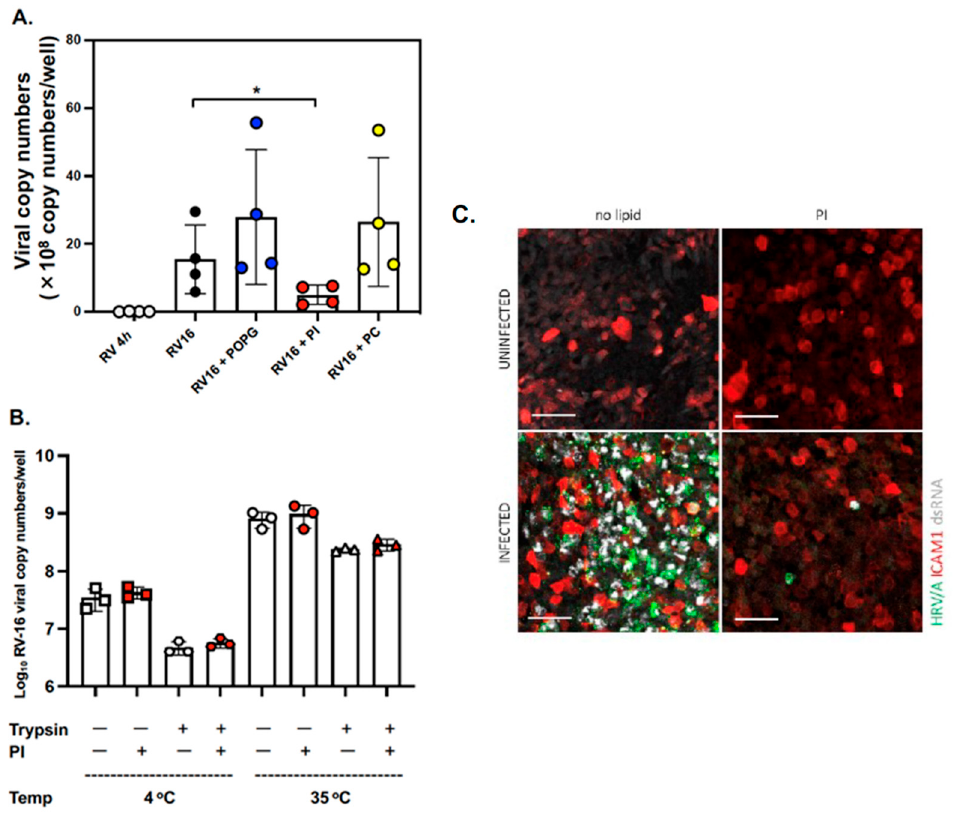
Figure 1. PI markedly inhibits RV-A16 replication but does not prevent viral internalization in AECs. ( A ) The data are from cells obtained from 4 different donors and are shown as mean ± SD from 3 independent experiments with duplicated wells in each experiment. * indicates, p < 0.05 in comparisons between RV16 alone and RV16 + PI. ( B ) The data are from cells obtained from 3 different donors and are shown as mean ± SD. The differentiated AECs were pre-treated (or not) for 16 h with PI (4 mg/mL) and infected apically with RV-A16 at 2.5 × 10 5 pfu/well at 4 ◦ C or 35 ◦ C for 2 h. The cells were collected with or without trypsin/EDTA treatment before total RNA extraction to determine the viral RNA copy number using qRT-PCR. ( C ) Immunofluorescent staining of mock or RV-A16 infected AECs (48 h p.i.) that were treated (or not) with PI. Cells were stained with anti- ICAM1 antibodies (red) to confirm viral receptor expression, and anti-VP2 (green) and anti-dsRNA (white) antibodies to visualize virus-infected cells. The scale bar represents 50 µ